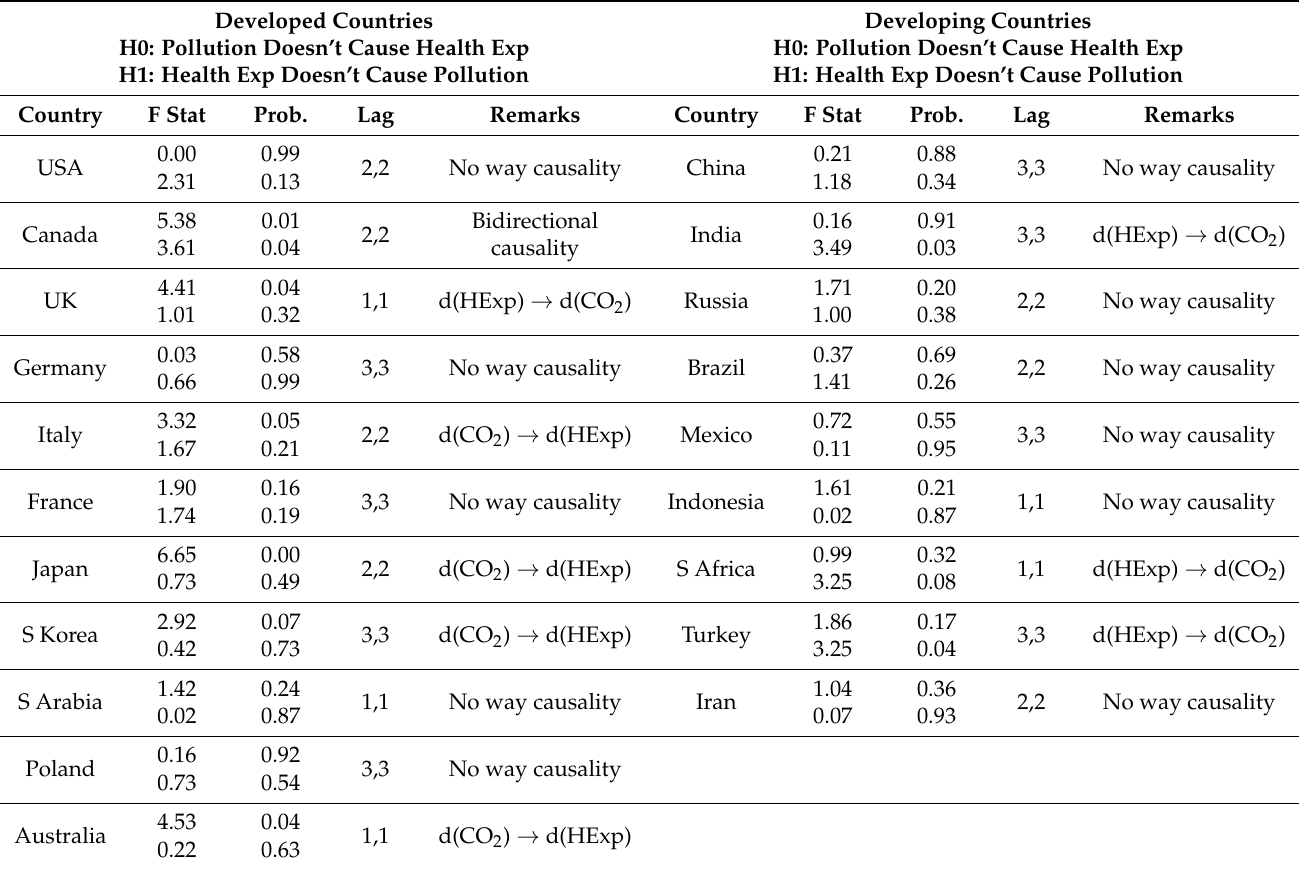
Table 4. Granger causality test results: Author’s own